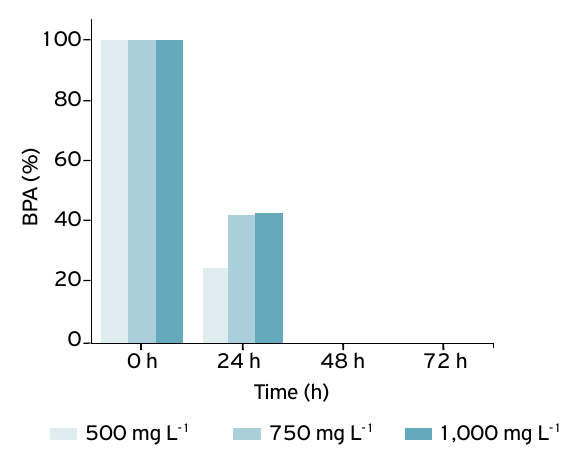
Figure 3. Relative percentage of BPA during treatment by